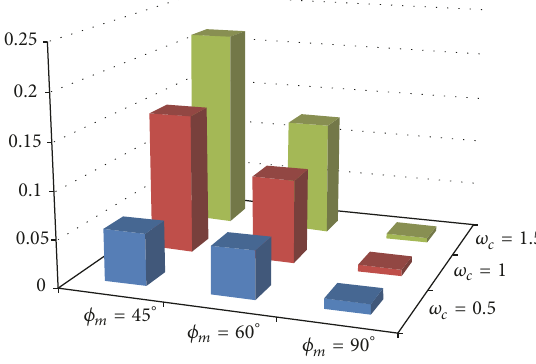
Figure 22: ITAE indices values of 𝑃 3 (𝑠)